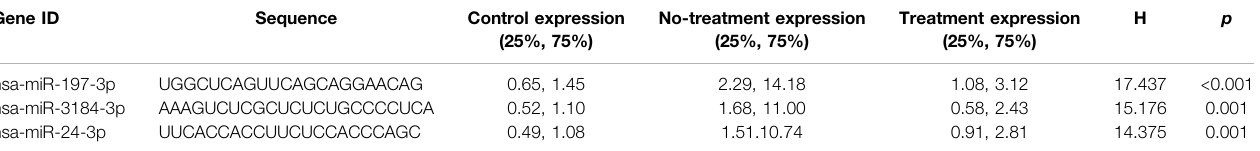
TABLE 3 | QPCR veri fi cation of a fl ibercept-induced miRNA pro fi le Gene ID